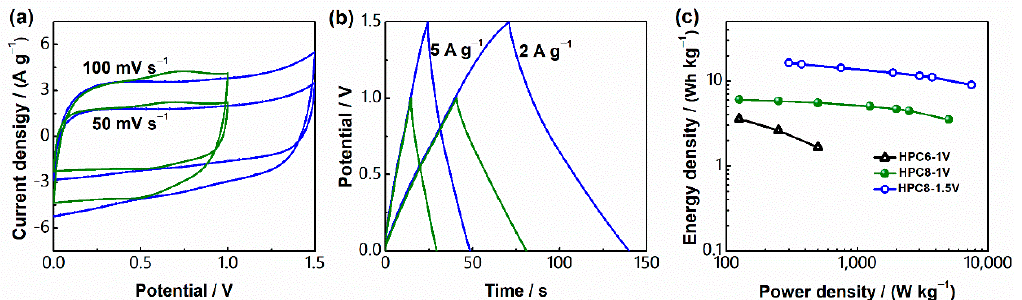
Figure 6. Supercapacitive performance for HPC-based symmetric supercapacitors with operation potential of 1 and 1.5 V: ( a ) CV curves for HPC8 at the scan rates of 50 and 100 mV s − 1 , ( b ) GCD curves for HPC8 at the current densities of 2 and 5 A g − 1 , ( c ) Ragone plot.